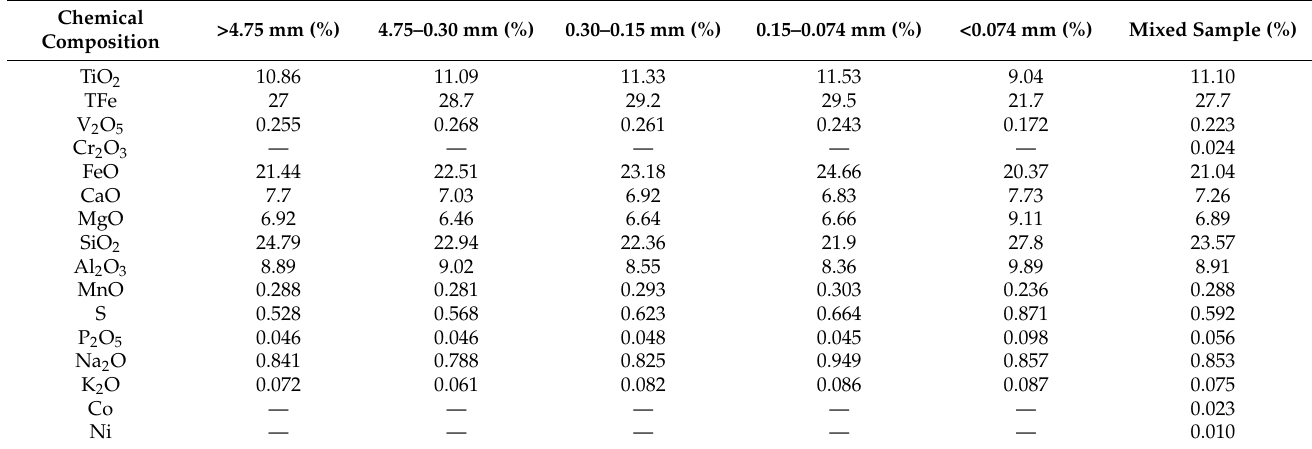
Figure 2. ( a ) Appearance and ( b ) particle size distribution of the ore samples. Table 2. Chemical composition of the ore for different particle size